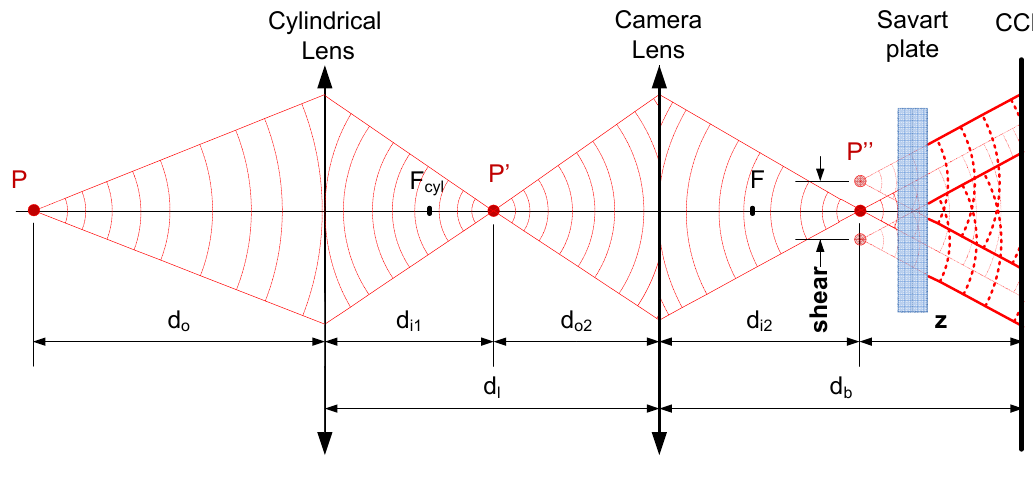
Figure 2. Schematic setup as observed from the direction perpendicular to the profile, zy plane (first appeared in [23], reprinted with